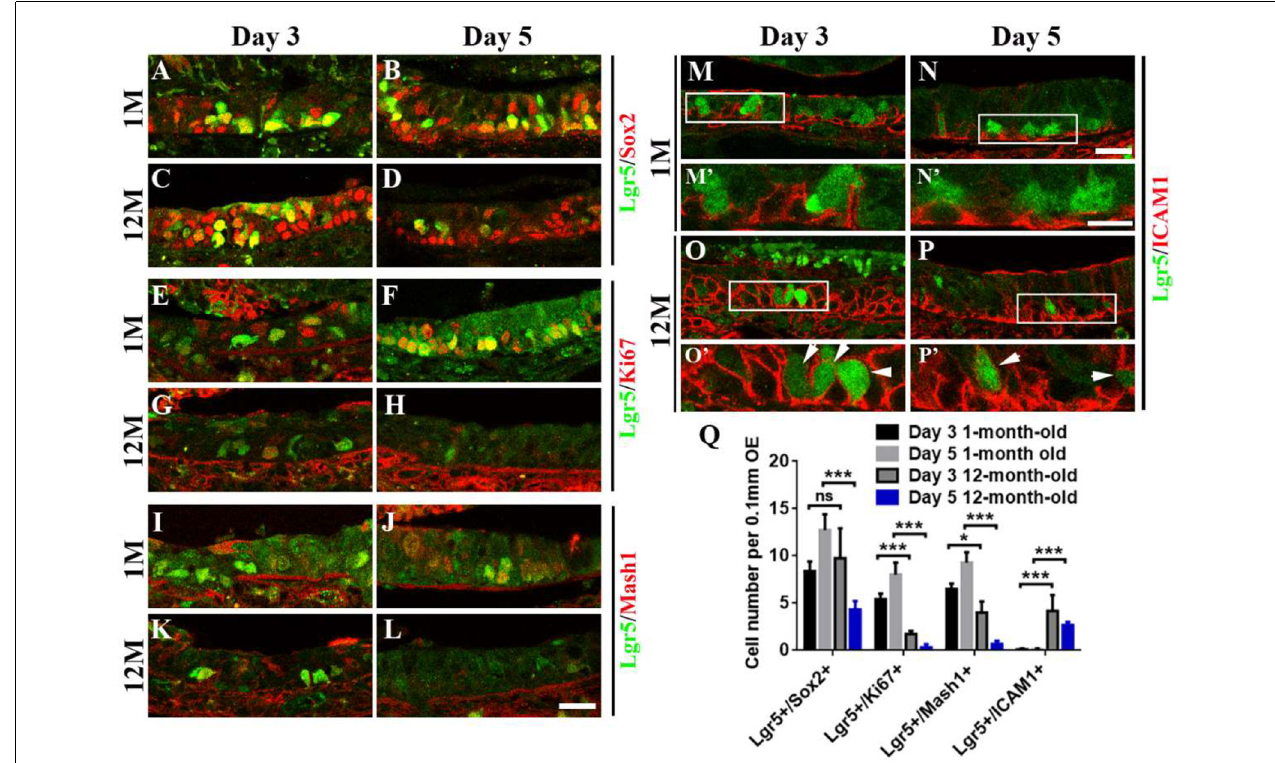
FIGURE 4 | Aging altered the stemness of Lgr5+ cells in injured OE. Immunostaining against GFP and basal cell marker Sox2 (A–D) , GFP and proliferative cell marker Ki67 (E–H) , GFP and GBC marker Mash1 (I–L) , GFP and HBC marker ICAM1 (M–P) in the OE of 1- and 12-month-old Lgr5-EGFP-CreERT2 mice at Days 3 and 5 postinjury. Panels (M’–P’) were the magnification of squared regions in (M–P) . Lgr5-EGFP+/ICAM1+ cells were labeled by arrowheads in (O’,P’) . (Q) Statistical analysis on the density of Lgr5+/Sox2+, Lgr5+/Ki67+, Lgr5+/Mash1+, and Lgr5+/ICAM1+ cells in the OE of 1- and 12-month-old mice at Days 3 and 5 postinjury. At Days 3 and 5 postinjury, 603 and 420 Lgr5+/Sox2+ cells, 147 and 336 Lgr5+/Ki67+ cells, and 156 and 390 Lgr5+/Mash1+ cells were counted in 1-month-old mice. At Days 3 and 5, 375 and 195 Lgr5+/Sox2+ cells, 57 and 19 Lgr5+/Ki67+ cells, 108 and 18 Lgr5+/Mash1+ cells, and 153 and 72 Lgr5+/ICAM1+ cells were counted in 12-month-old mice. The statistical significance was determined by two-way ANOVA. F (3,108) = 84.92, p < 0.0001. The asterisks were determined by Tukey’s multiple comparisons test. Scale bars: 20 µ m in (L,N) and 10 µ m in (N’) ; ns, not significant.